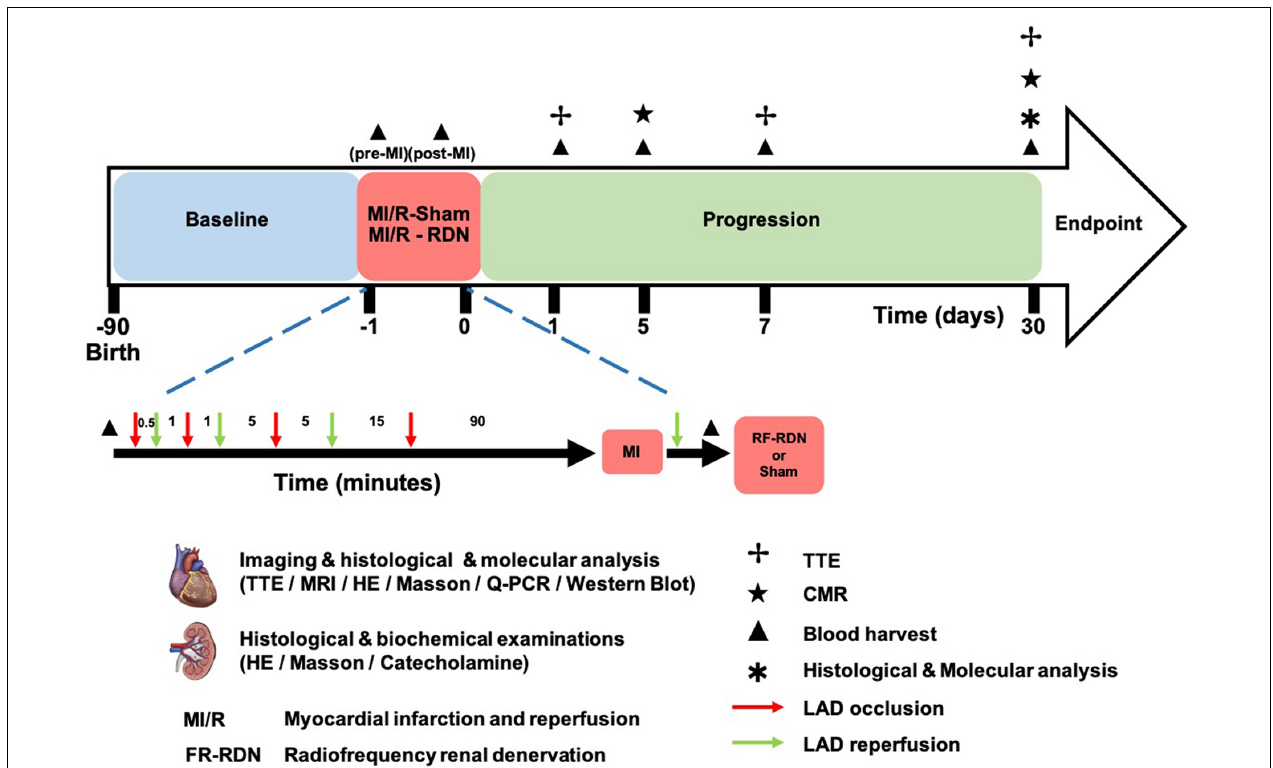
FIGURE 1 | MI/R-RDN experimental protocols. Preconditioned minipigs were subjected to triple episodes of 30 s, 1 and 5 min occlusion followed by 1, 5, and 15 min reperfusion, respectively, before the prolonged ischemia. Then LAD was occluded for 90 min followed by reperfusion before they were immediately treated with sham- or RF-RDN. TTE was performed at 1, 7, and 30 days after RDN therapy. CMR was performed at 5 and 30 days after RDN therapy. Peripheral blood was collected pre-MI/R, post-MI/R, and 1, 5, and 30 days post-MI/R. HE, hematoxylin and eosin; LAD, left coronary artery descending; TH, tyrosine